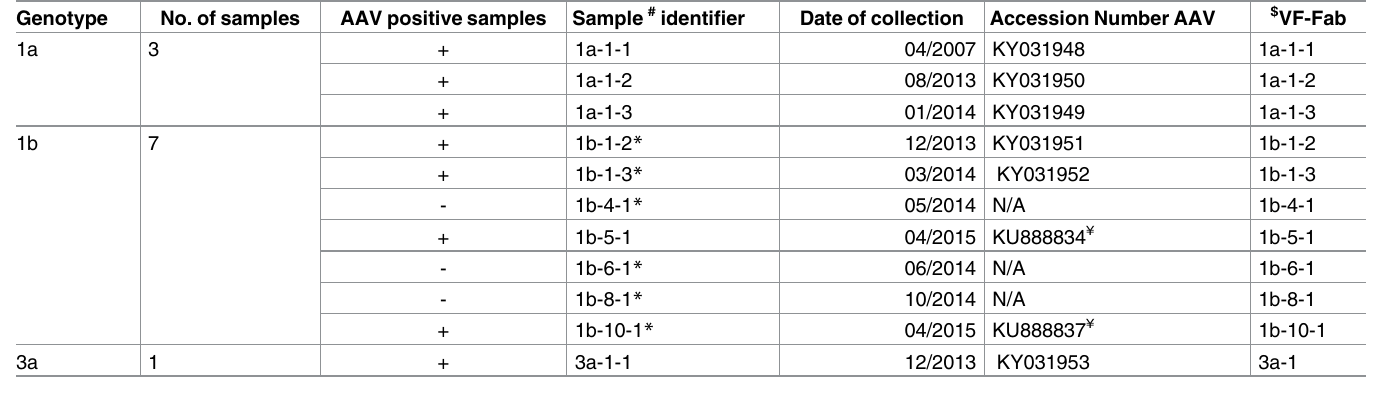
Table 2. Sample characteristics used in the current study.